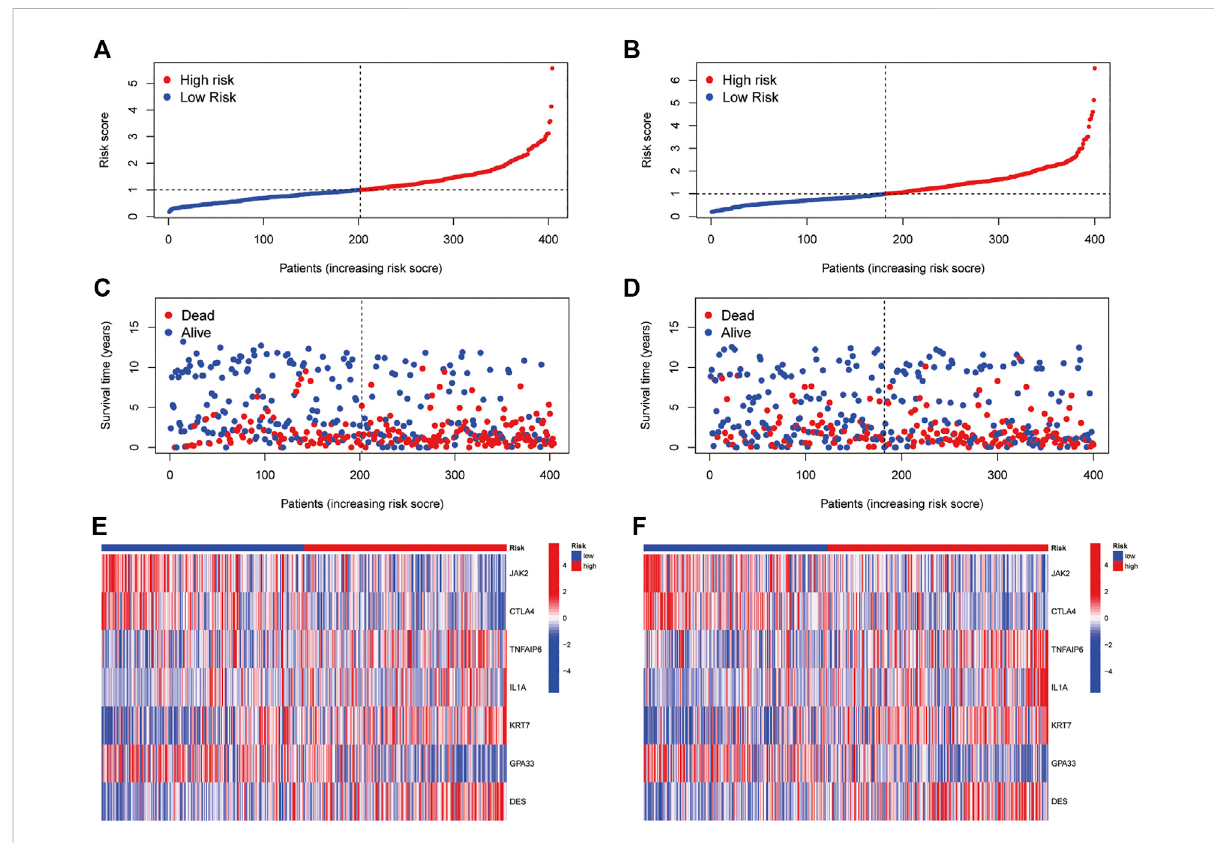
FIGURE 5 Prognostic value of the pyroptosis-associated DEG signature in the training and test cohorts (A,B) RS distribution (C,D) Survival status of GC patients (E,F) Heatmap of the 7